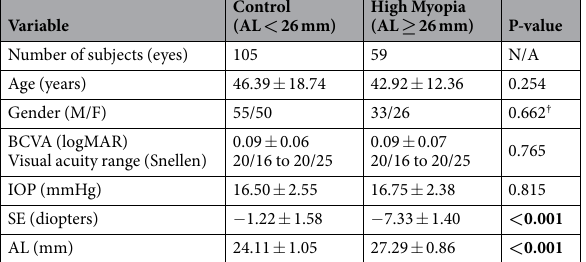
Table 1. Characteristics of high myopia and control groups. M, male; F, female; BCVA, best-corrected visual acuity; IOP, intraocular pressure; SE, spherical equivalent; AL, axial length; N/A not applicable. Values are presented as mean ± standard deviation (count). P values were yielded by student t-test for comparing continuous values. † P values were yielded by Chi-square statistics for comparing categorical values. * Bold values indicate statistically significant differences (P <